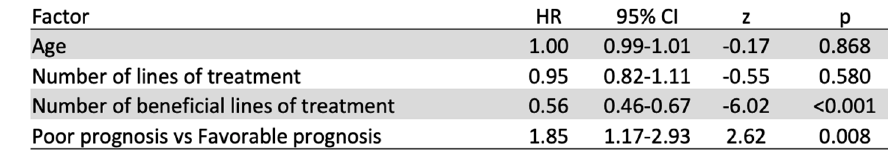
Figure 5. The number of beneficial lines of treatment and the IMDC risk prognostic score were both significantly correlated with OS. Cox regression multivariate testing of the relationship between the following factors: Age, number of treatment lines, number of beneficial lines of treatment, and intermediate- or poor-risk versus favorable-risk prognosis.